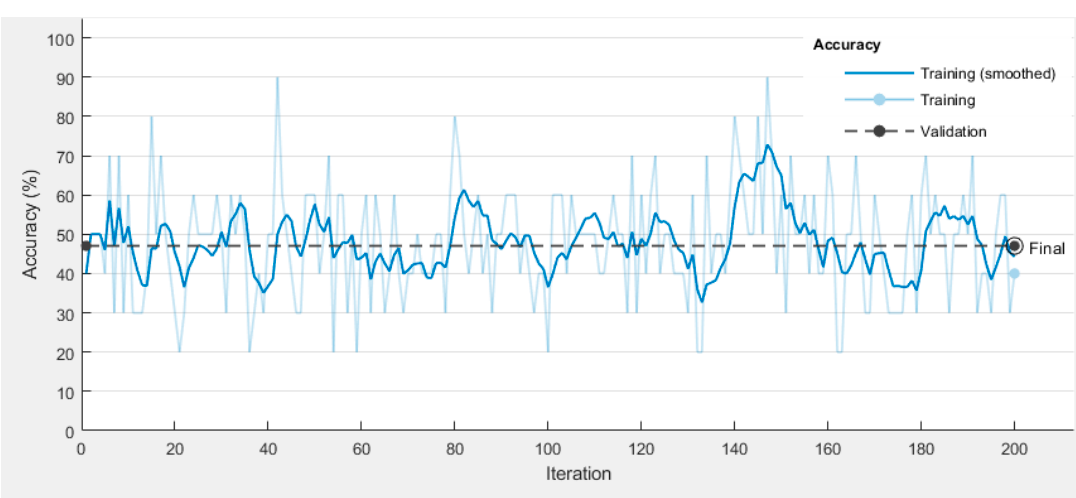
Figure 12. Example of accuracy evolution.